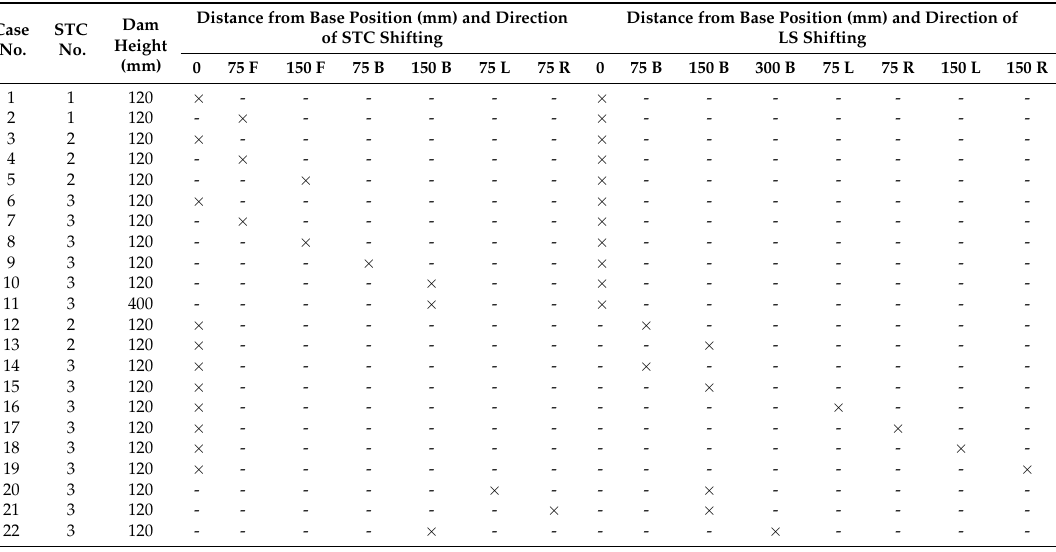
Table 1. Considered variants of STC and ladle shroud (LS) mutual positions in the tundish pouring